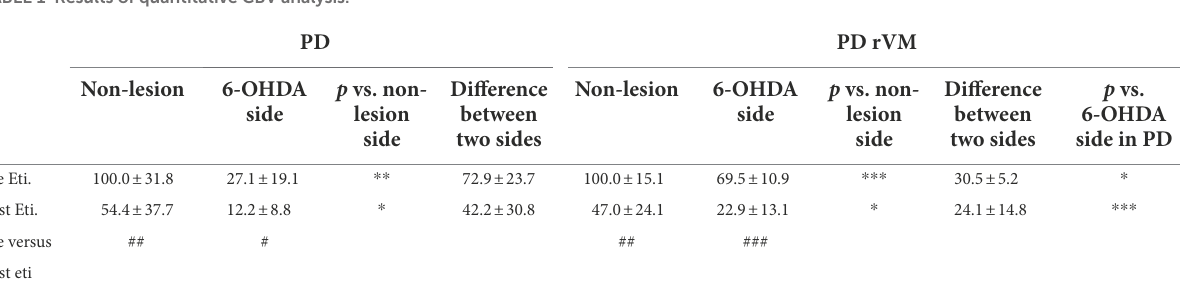
TABLE 1 Results of quantitative CBV